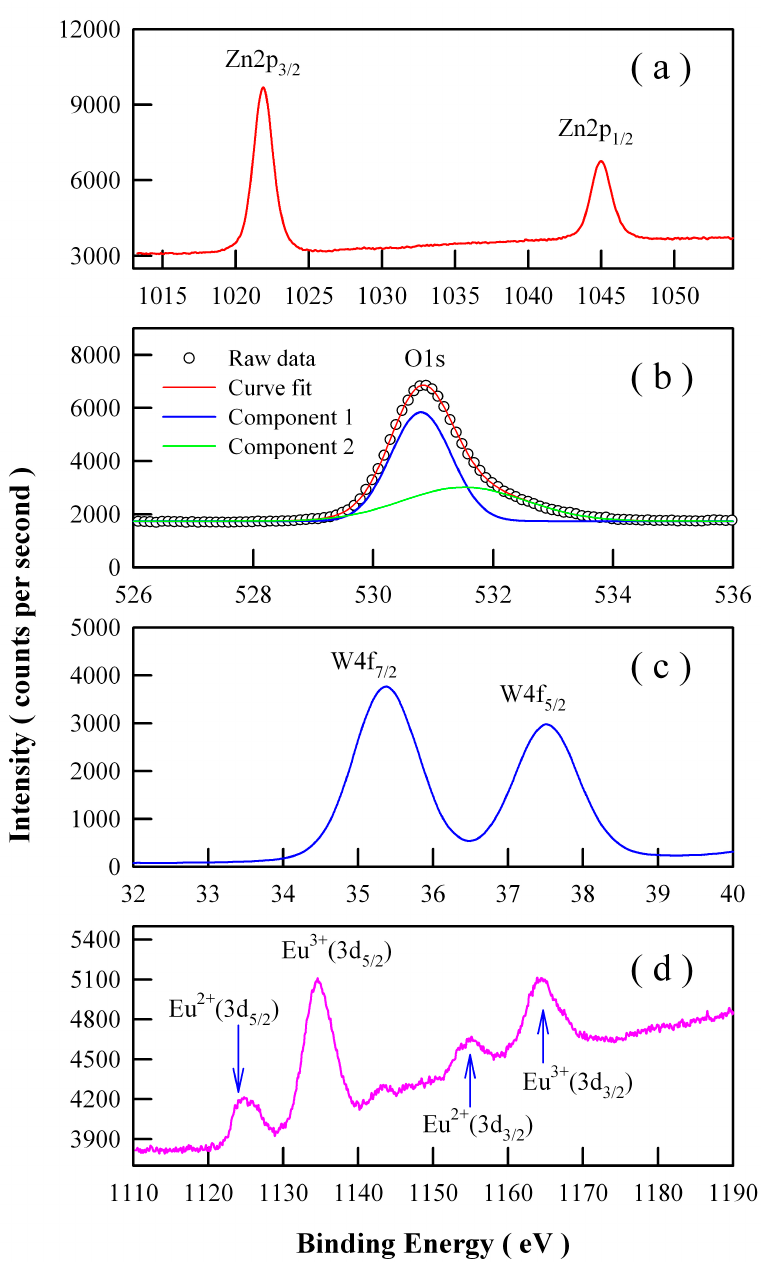
Figure 7. High-resolution XPS spectra of Eu-doped ZnWO 4 precursors subjected to annealing at 400 ºC: ( a ) Zn2p 3/2 and Zn2p 1/2 ; ( b ) O1s; ( c ) W4f 7/2 and W4f 5/2 ; ( d ) Eu3d 3/2 and Eu3d 5/2 .